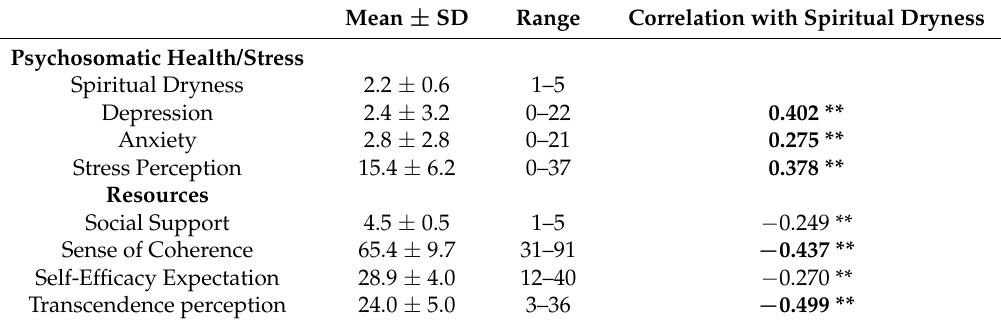
Table 2. Mean values and correlation of spiritual dryness scores with other variables. Mean ± SD Range Correlation with Spiritual Dryness